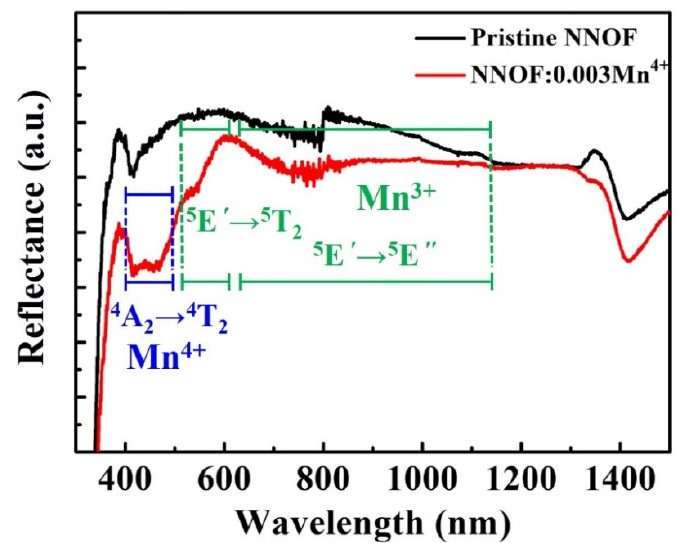
Figure 6. Diffuse reflection spectra of pristine NNOF and NNOF:0.003Mn 4+ , 4 A 2 and 4 T 2 are the ground state and excited state of Mn 4+ , respectively, 5 E ′ and 5 E ″ are two Jahn-Teller split 5 E ground states and 5 T 2 is the excited state of Mn 3+ .